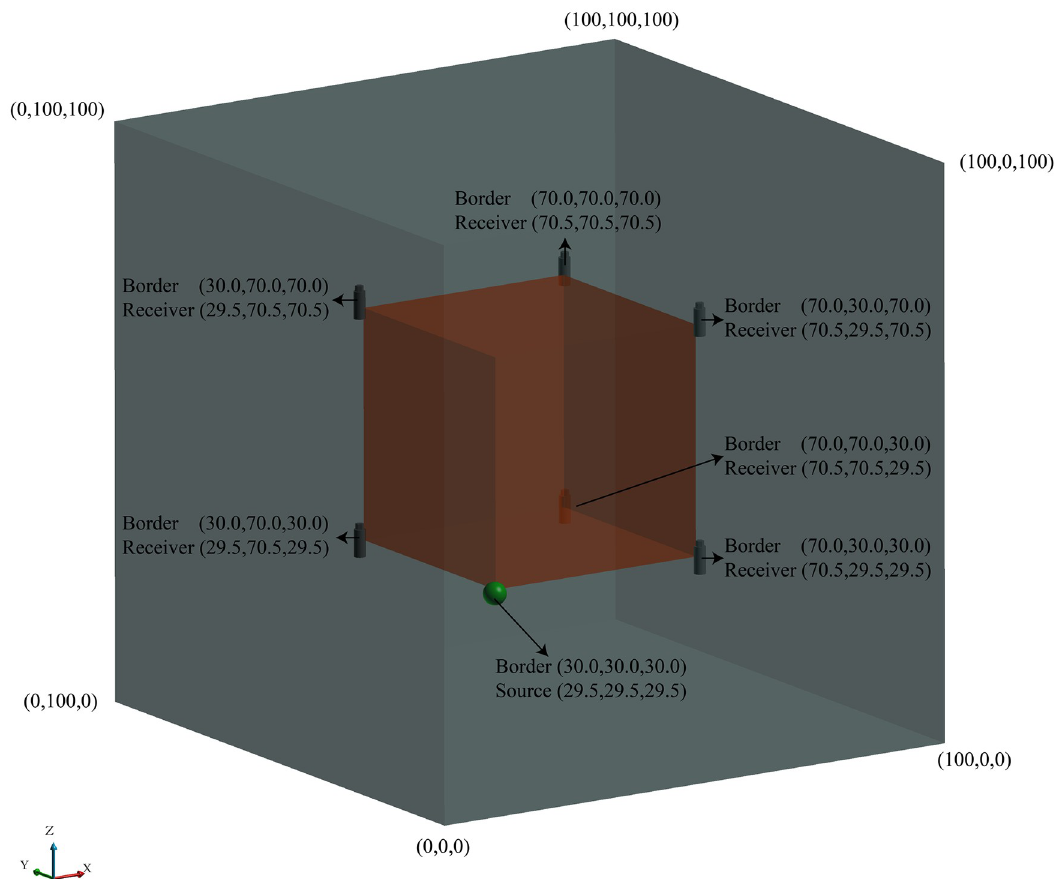
Fig 5. An idealized model. The model size is 100 m × 100 m × 100 m, and a void is located inside the cube. The border of the void is defined by the coordinates shown in the figure. The source is denoted by the green sphere, and the receivers are denoted by gray cylinders.